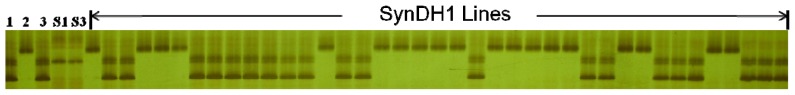
SSR amplification patterns of marker Xwmc312. Compared to their parents AS60 (1); LDN (2) and AS313 (3); S1 (lane S1) and S3 (lane S3) of SynDH1 line 61 showed novel SSR patterns. AS313 and AS60 had same SSR pattern. SSRs from AS60 (1) were absent in SynDH1 line 61 (S1 and S3) and these SynDH1 lines carrying LDN allele. The SSRs in other SynDH1 lines should be the products of AS313 allele (3) rather than AS60 (1) due to a competition for PCR amplification.